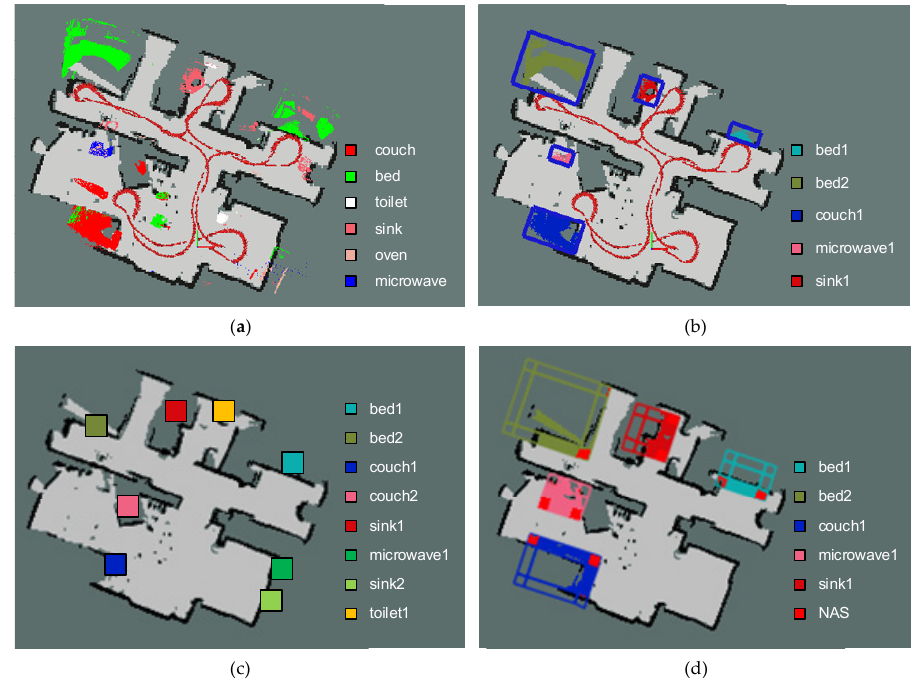
Figure 14. The results of the alma scene: ( a ) original point cloud, ( b ) point cloud with bounding rectangles, ( c ) the ground truth, and ( d ) the object semantic grid map. Table 1. The statistical results of the alma scene.